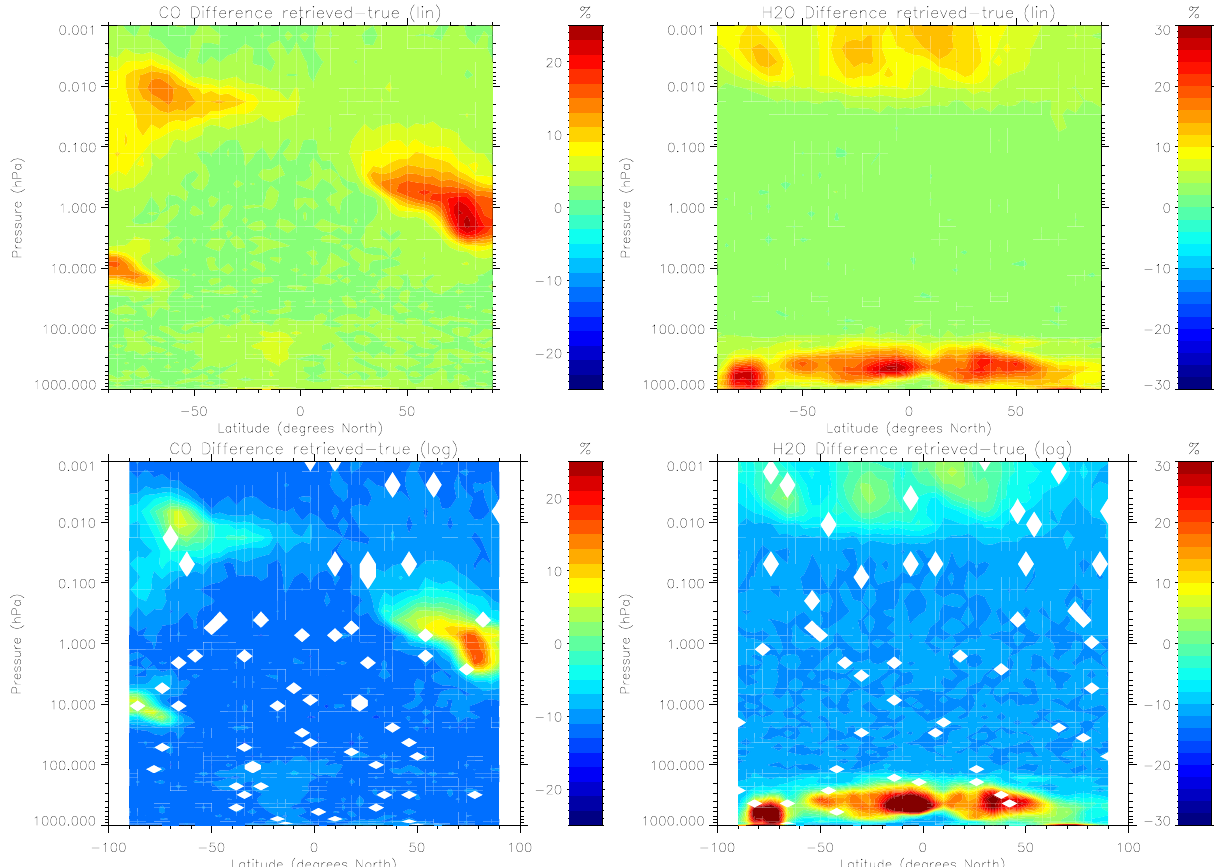
Fig. 3. Zonal mean differences of retrieved and “true” distributions (relative to the latter) for CO (left) and H 2 O (right). Top: linear averages, bottom: logarithmic averages. Results are shown for maximum likelihood ln(vmr)-retrieval simulations with a signal to noise ratio of 2. White regions in the lower panels reflect unreasonable results (“zero” averages, see text for further explanations).